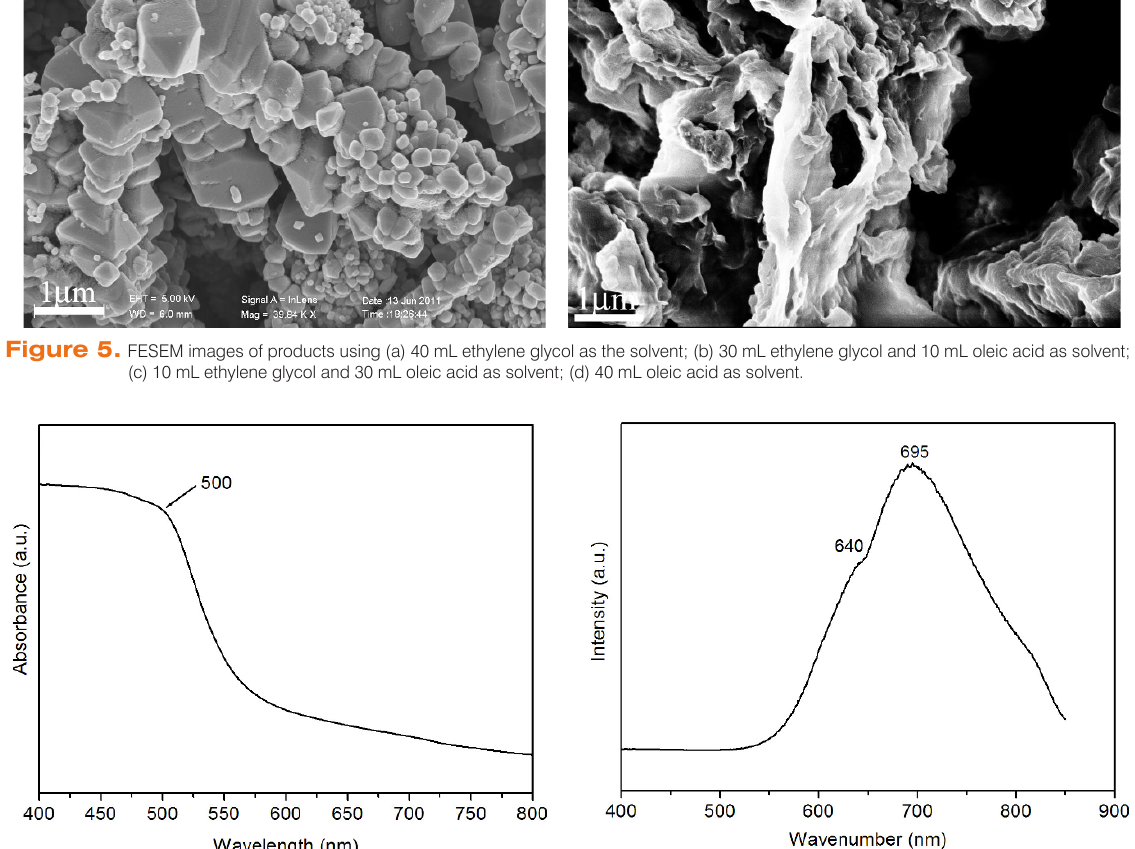
Figure 6. UV–vis absorption spectrum of the polyhedral CdS flower-like architectures at room temperature.